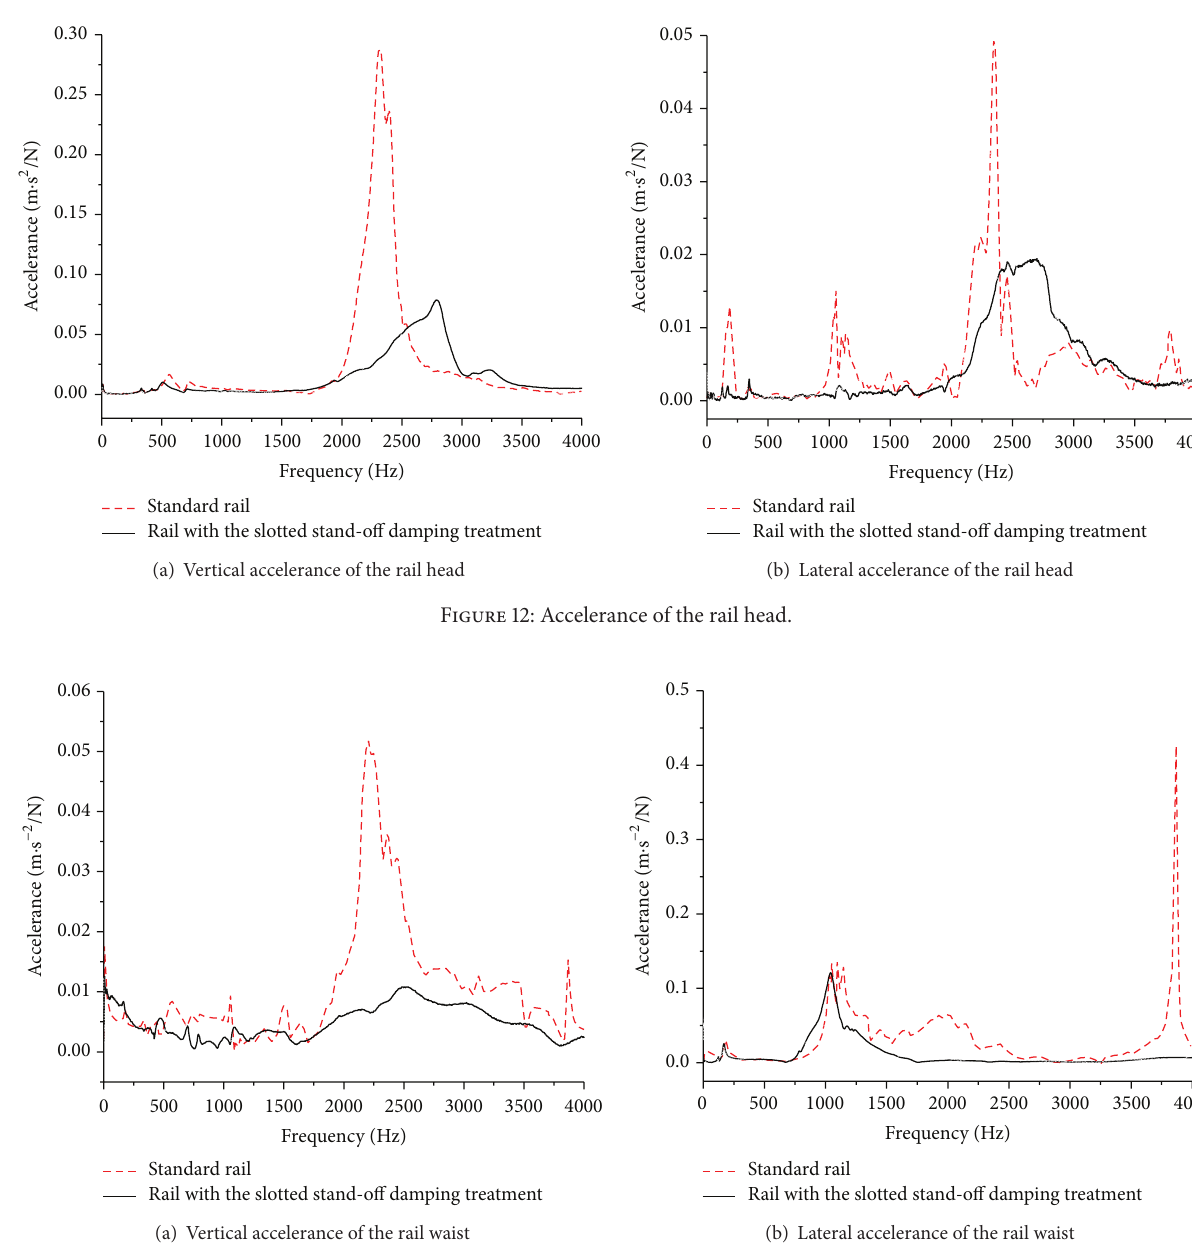
Figure 13: Accelerance of the rail